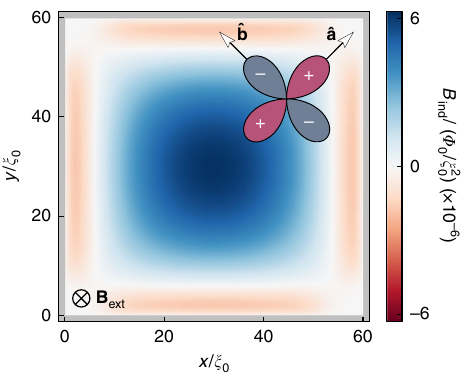
Fig. 8 Grain geometry. The system consists of a d -wave superconducting b z . The crystal ab - grain exposed to an external magnetic fi eld B ext = (cid:1) B ext axes are rotated 45° relative to the grain edges, inducing pair breaking at the edges of the system. The color scale shows the magnetic fi eld B ind induced in response to an external fi eld of size B ext = Φ 0 /2 A at a temperature T = 0.2 T c . There is a diamagnetic response carried by the condensate in the interior, and a paramagnetic response carried by midgap surface Andreev states at the